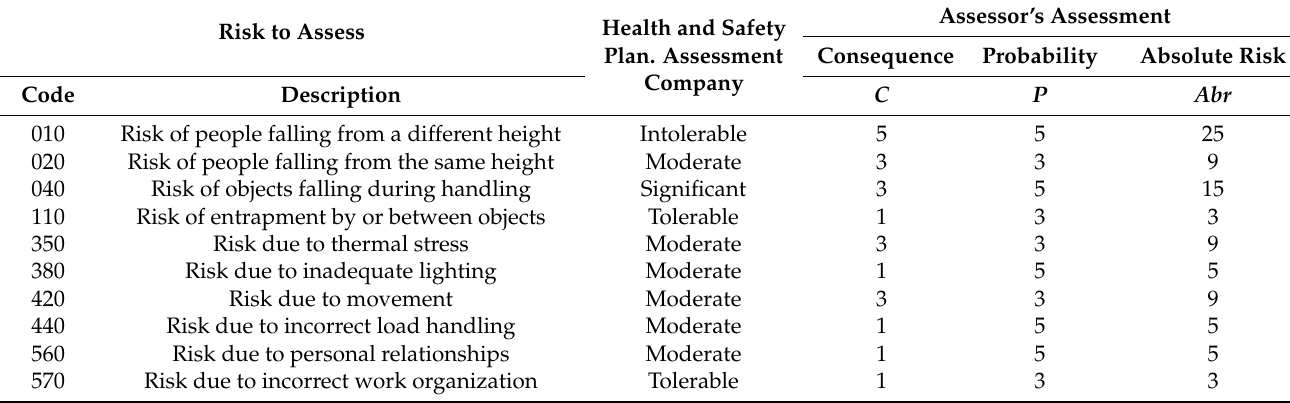
Table 5. Interpretation of the health and safety plan assessment.